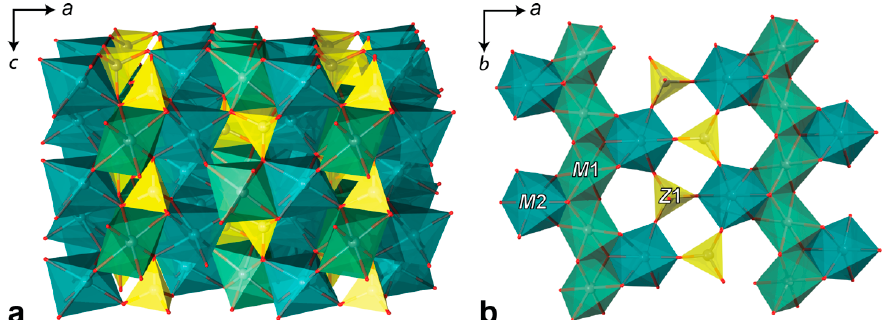
Figure 10. Crystal structure of forsterite (1): a general view ( a ) and heteropolyhedral sheet based on M 1, M 2 octahedra (green) and Z 1 tetrahedra (yellow) projected along c axis ( b ).